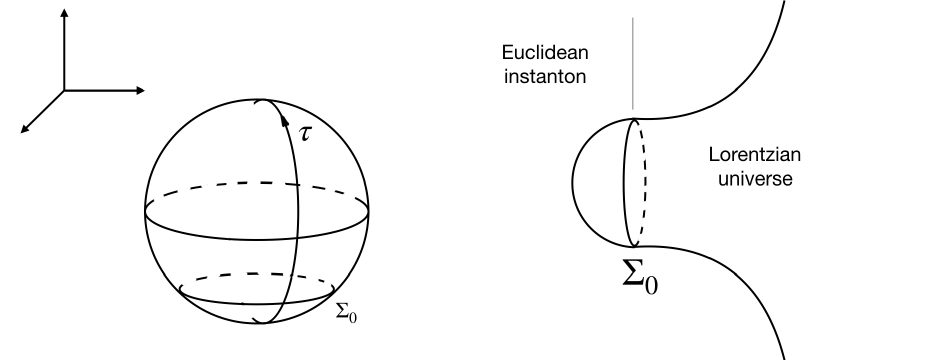
Figure 8. Left : a DeSitter instanton can be seen as a 4-dimensional sphere in the 5-dimensional Euclidean flat spacetime. Right : the creation of a DeSitter spacetime from a DeSitter instanton of the Euclidean sector of the